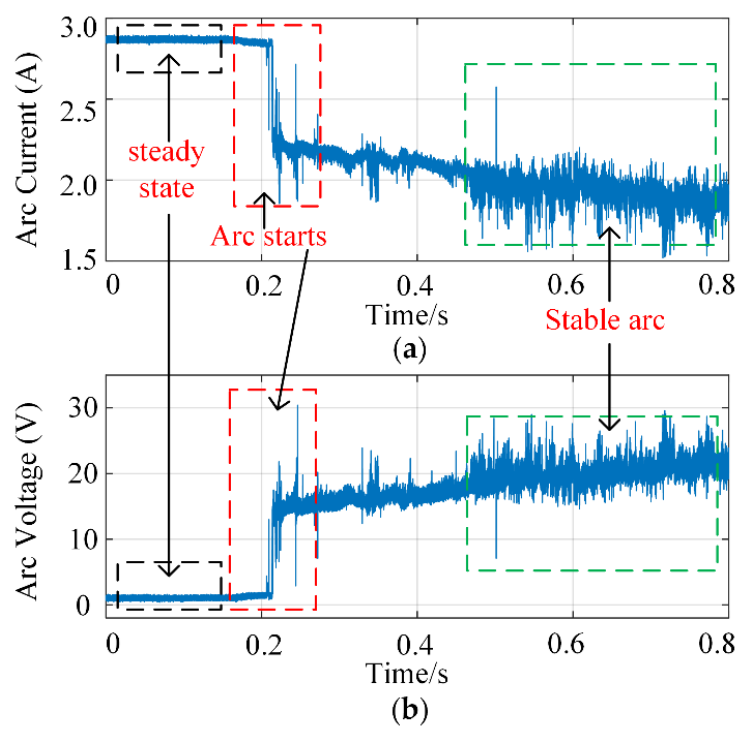
Figure 10. Arc waveforms. ( a ) Arc current waveform; ( b ) Arc voltage waveform.